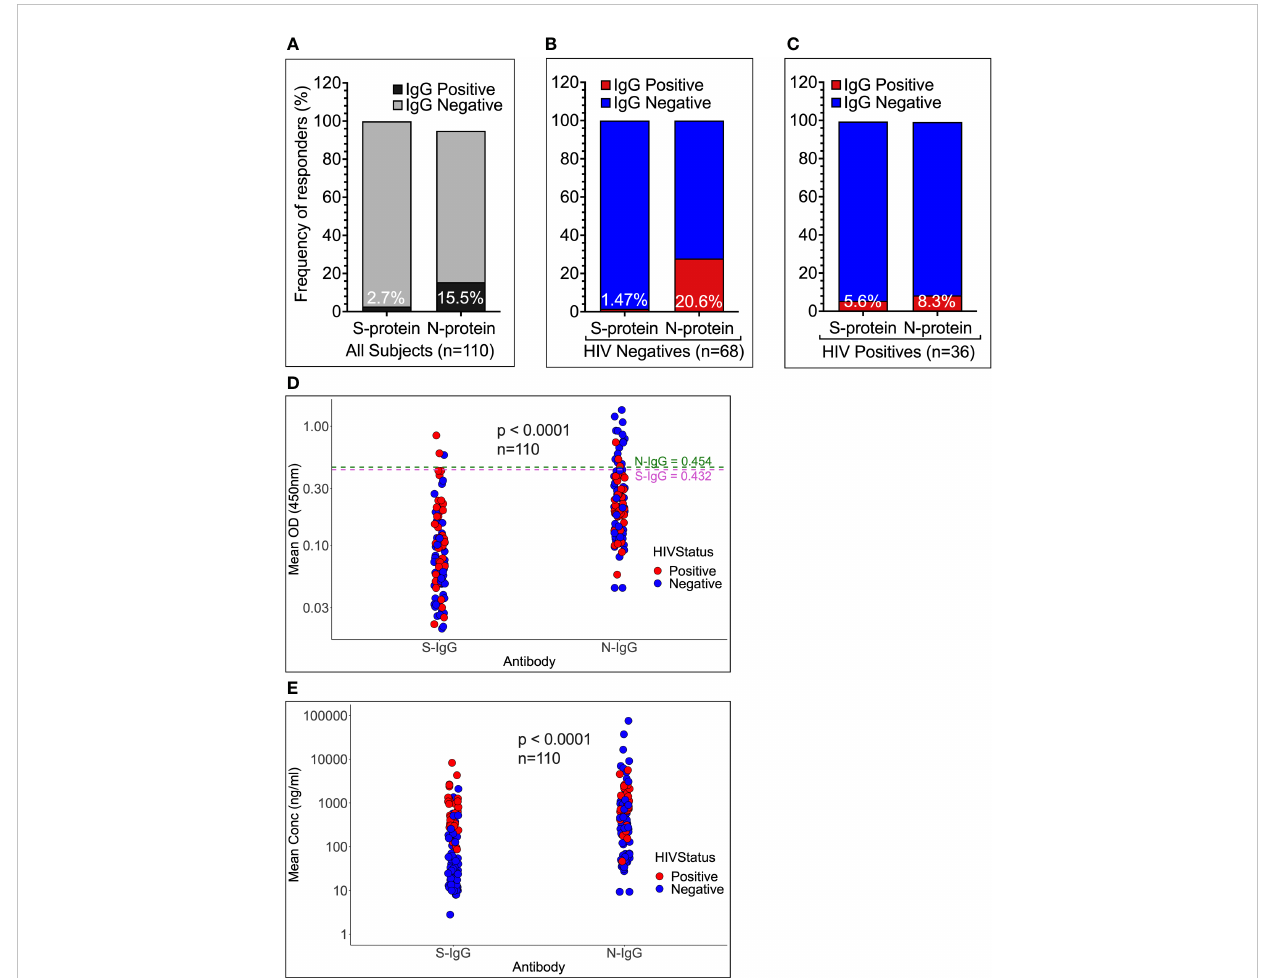
FIGURE 4 Frequencies and magnitudes of SARS-CoV-2 -speci fi c cross-reactive IgG binding antibodies by HIV status. The frequency of pre-epidemic cross- reactive anti-SARS-CoV-2 binding IgG antibodies in Ugandan pre-pandemic sera is depicted in Figure 4. 110 specimens (A) were strati fi ed by HIV-1 negative (B) and positive serostatus (C) , and the proportions of subjects with cross-reactive IgG binding antibodies against the SARS-CoV-2 spike and nucleoprotein illustrated. (D, E) summarises the medians of means of duplicate IgG antibody OD values in nm and concentration levels in ng/ml, respectively. The cut-off OD values are shown by the dashed